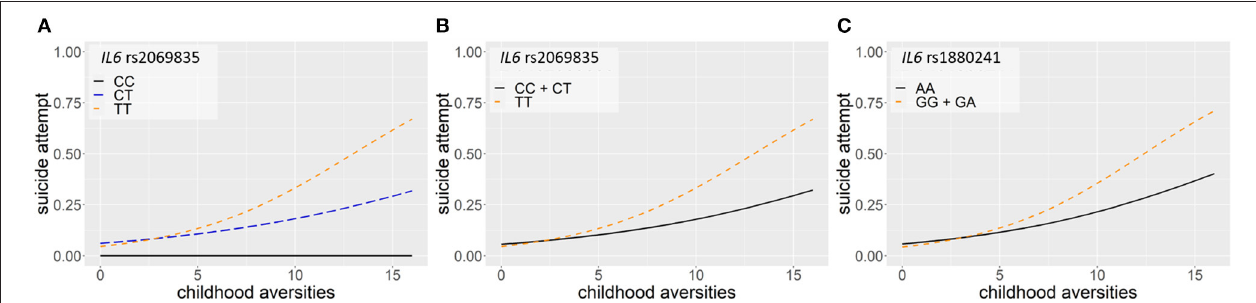
FIGURE 2 | Logistic regression models on the interaction between IL6 and childhood adversities on history of lifetime suicide attempts yielded three significant clumps (one for additive and two for dominant models), surviving correction for multiple testing. In the additive model, a clump containing three SNPs emerged with rs2069835 as the top SNP and the minor C allele as a protective allele ( p = 0.0004) (A) . In the dominant model, a clump containing 4 SNPs with rs 2069835 as the top SNP and the minor C allele as a protective allele ( p = 0.0004) (B) , and another clump containing 3 SNPs, with rs1880241 as the top SNP and the minor G allele as a risk allele ( p = 7.08 × 10 − 5 ) (C) was identified. The figure was generated for illustration purposes using R.